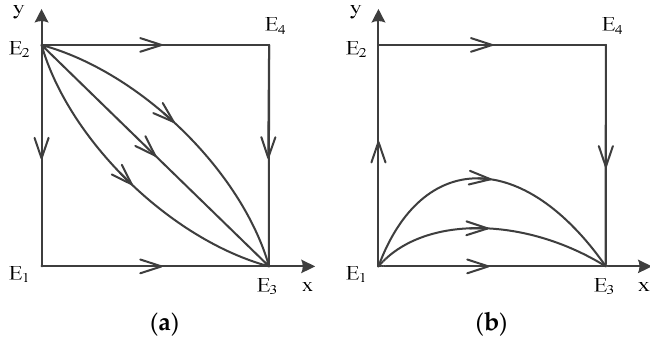
( ) 1,0 E 3 , ( a ) Case7 ( b ) Case 8.